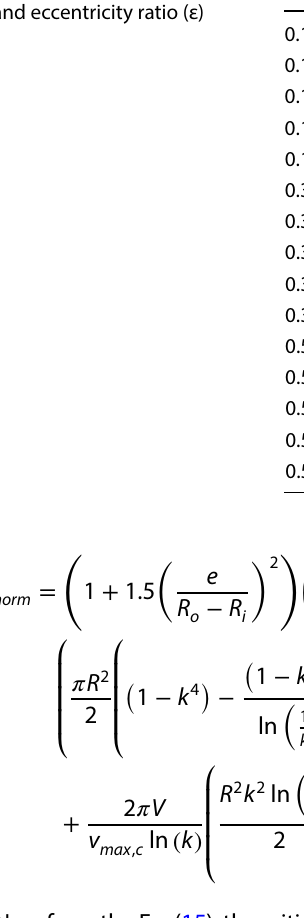
Table 2 Calculation of radial dimensions for the various planes for different radius ratio (k) and eccentricity ratio